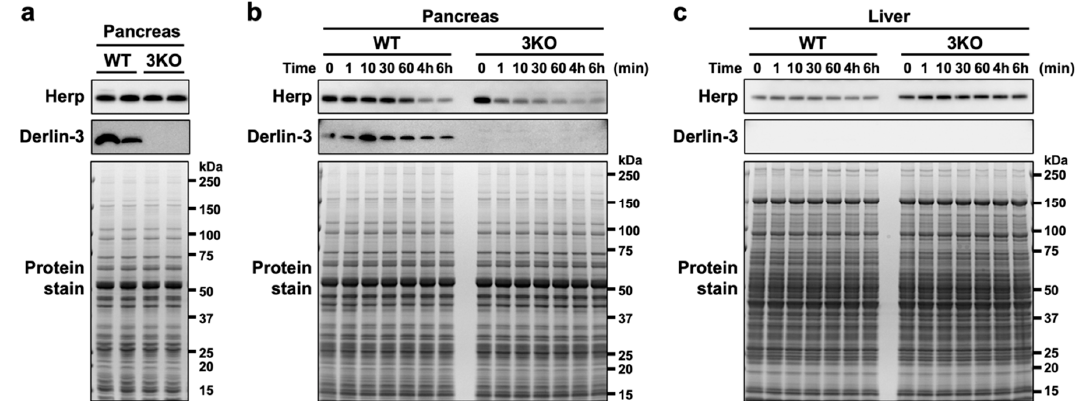
Figure 2. Rapid degradation of Herp in the Derlin-3-deficient pancreas. WT and 3KO mice were fasted for 12 h before euthanasia. Pancreas ( a , b ) and liver ( c ) homogenates in SDS sample buffer ( a ) or phosphate-buffered saline (PBS) ( b , c ) were incubated on ice for the indicated times (0–60 min, 4 h, and 6 h). The homogenates were subjected to a Western blotting analysis using antibodies indicated on the left side. Bottom images (Protein stain) show protein bands in the gel stained with GelCode Blue Stain Reagent to check for equal loading.